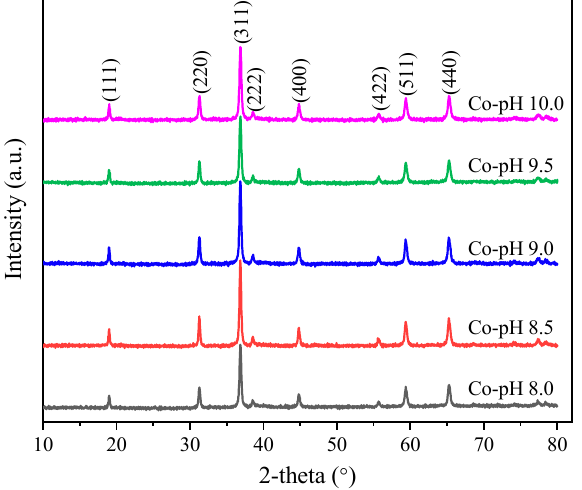
Figure 3. X-ray di ff raction (XRD) patterns of cobalt oxides prepared at di ff erent pH Figure 3. X-ray diffraction (XRD) patterns of cobalt oxides prepared at different pH values.